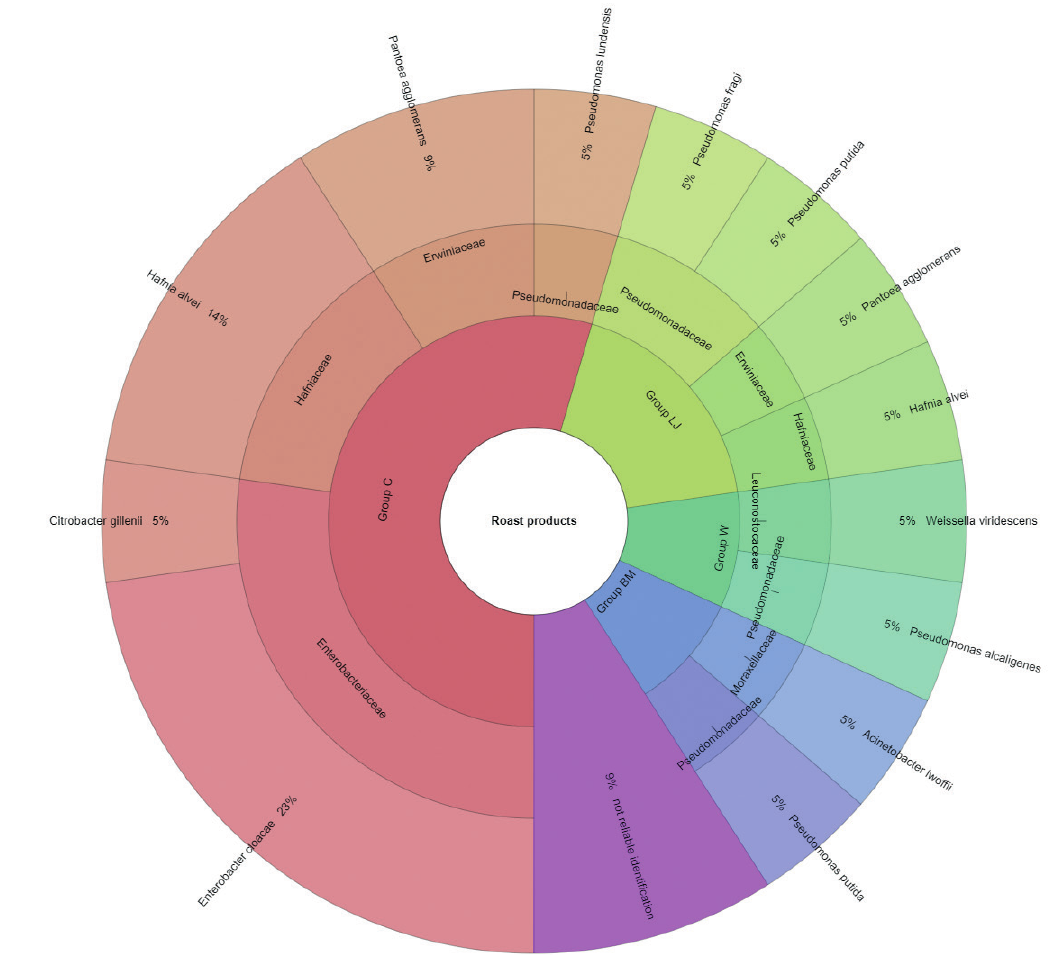
Figure 2. Identified species and family of bacteria isolated in the roast